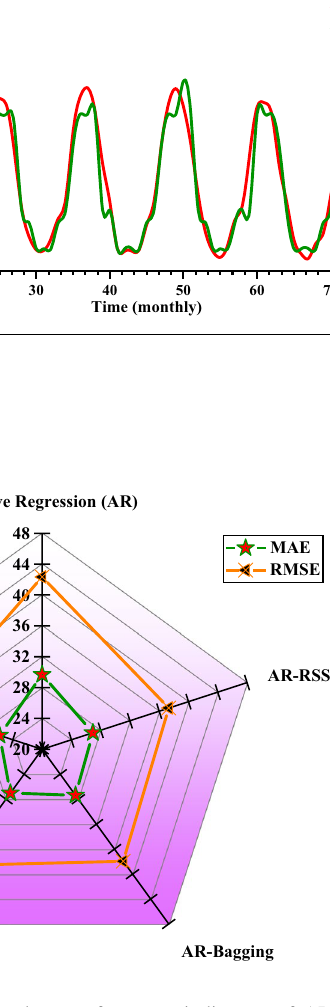
Fig. 9 Radar charts display the best performance indicators of AR, AR-RSS, AR-Bagging, AR-REPTree, and AR-M5P models during testing at Mosul station Fig. 10 Taylor diagrams of AR, AR-RSS, AR-Bagging, AR-REP- Tree, and AR-M5P during testing span at Mosul station Table 9 Validation results (i.e., MAE, RMSE, RAE, RRSE, and r ) for best candidate model at Basrah